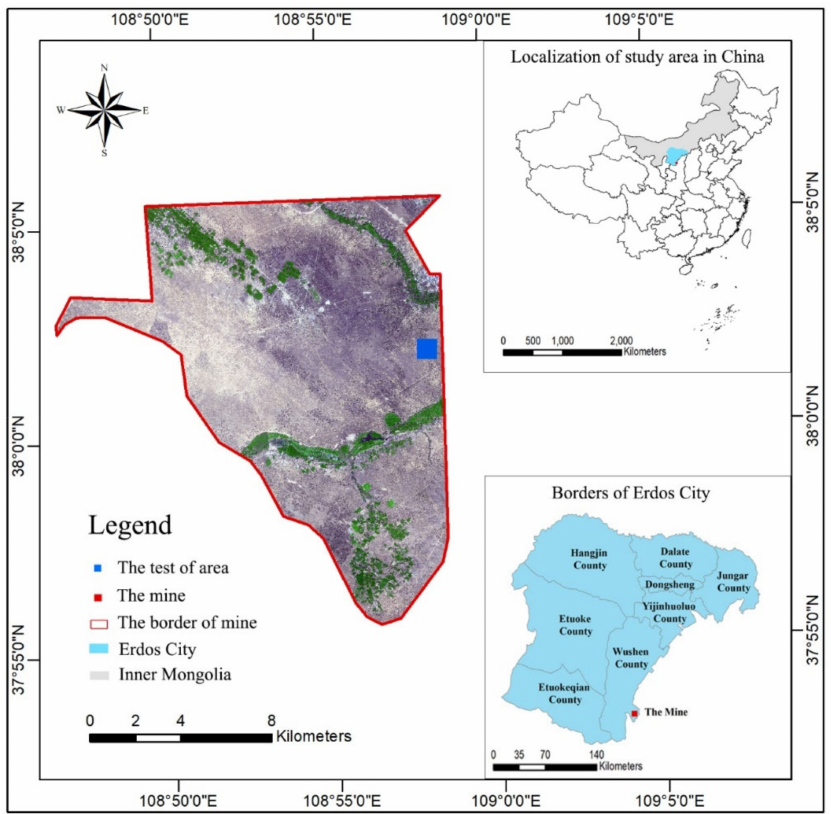
Figure 1. Location map of the No. 2 mine field of Nalin